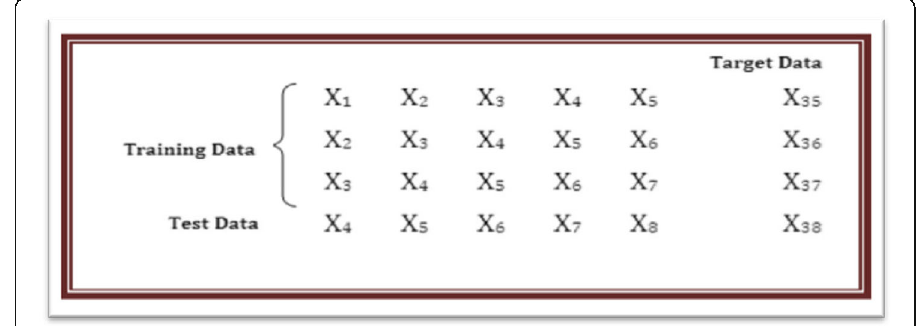
Fig. 9 Training window generation for one-month-ahead